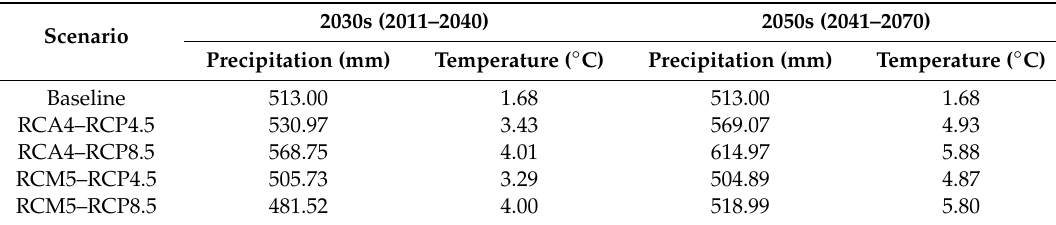
Table 5. Annual average precipitation and temperature for baseline and future climate projections.